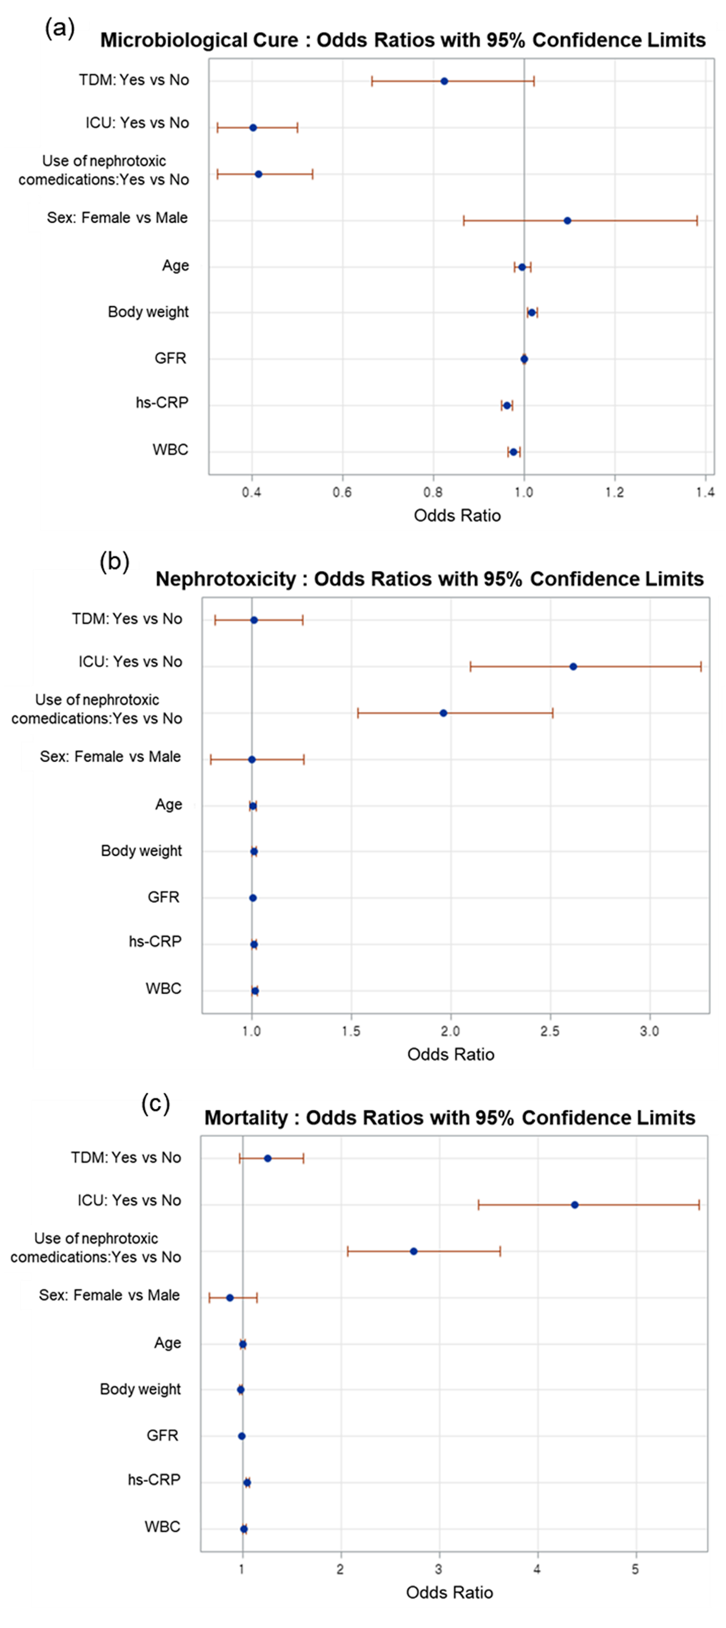
Figure 1. Odds ratios and their 95% confidence limits by TDM and other covariates for ( a ) microbio- logical cure, ( b ) nephrotoxicity, and ( c ) mortality: multiple logistic regression analysis. Abbreviations: TDM (therapeutic drug monitoring); ICU (intensive care unit); GFR (glomerular filtration rate); hs-CRP (high sensitivity C-reactive protein); WBC (white blood